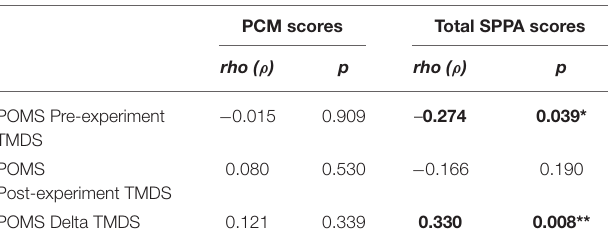
TABLE 3 | Spearman’s rho ( ρ ) correlations between PCM and total SPPA scores, and pre-experiment, post-experiment, and delta POMS